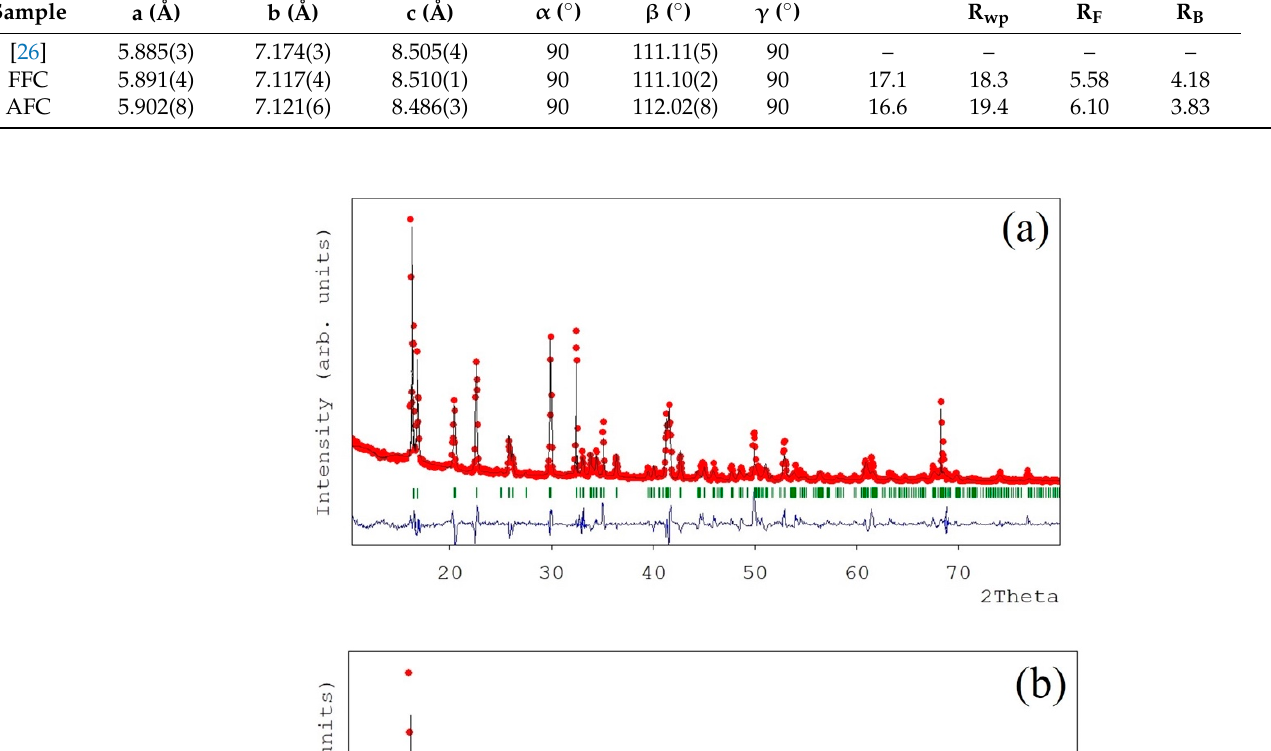
Table 2. Lattice parameters and cell angles calculated from the Rietveld refinements for the obtained samples. Sample